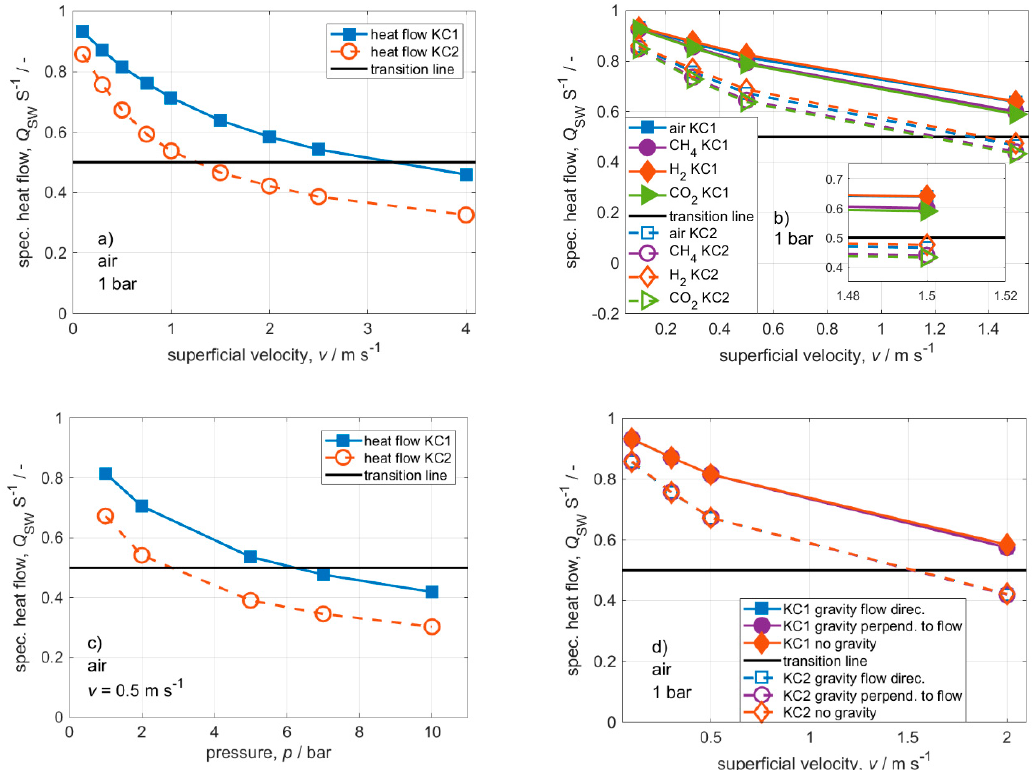
Figure 2. Heat flows for fluid property variation ( a ) Increase in inlet velocity incl. turbulence modelling; ( b ) Influence of fluid type; ( c ) Influence of pressure; ( d ) Influence of gravitational acceleration. Conditions: S = 12.5 W; λ s = 5 W m − 1 K − 1 .